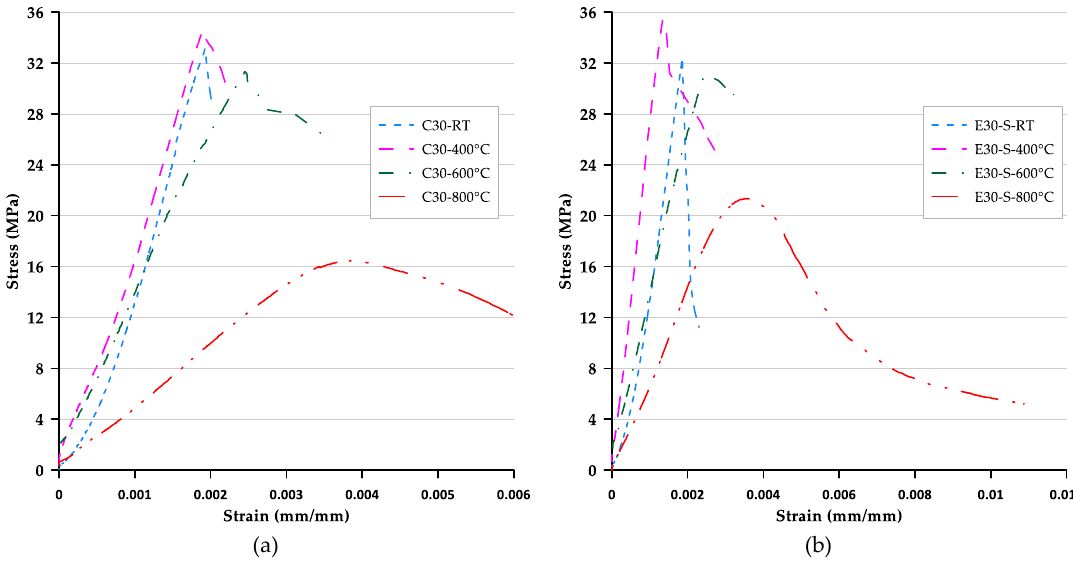
Figure 6. Stress versus strain curves of low-strength LWC specimens: ( a ) control group C30 and ( b ) experimental group E30-S.